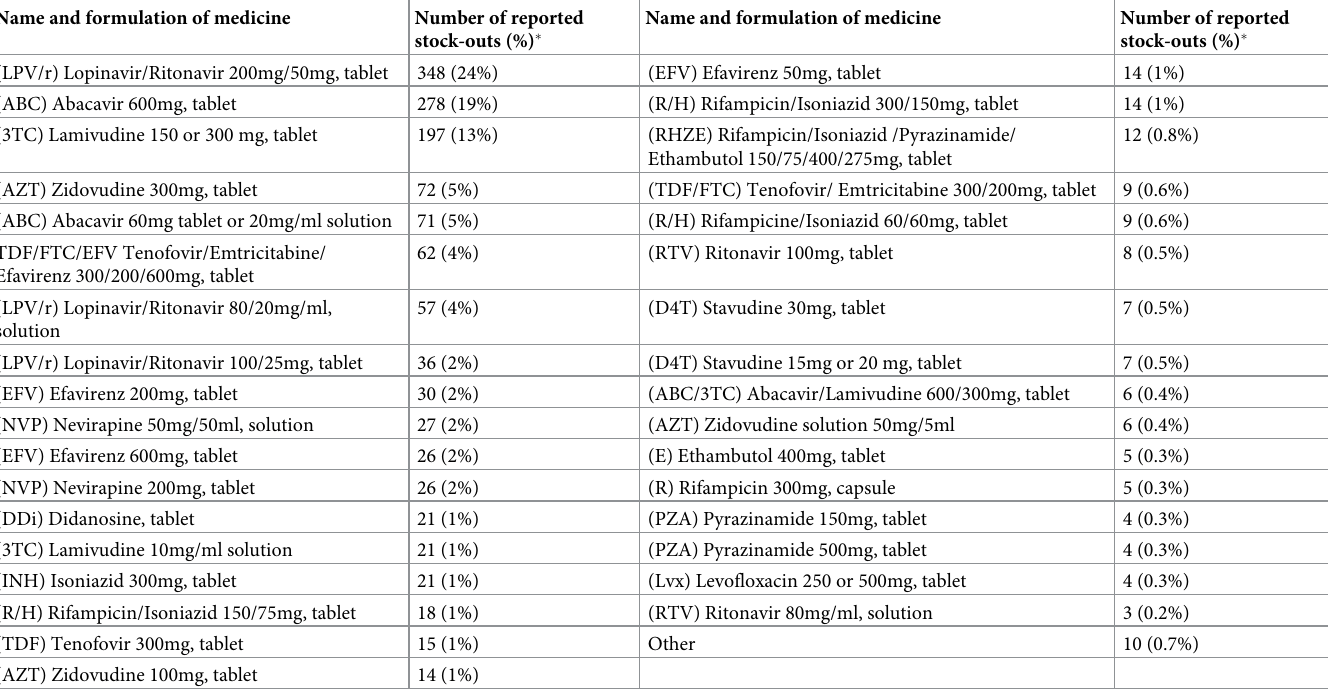
Table 3. Medicines reported out of stock during the three months prior to contact in South African